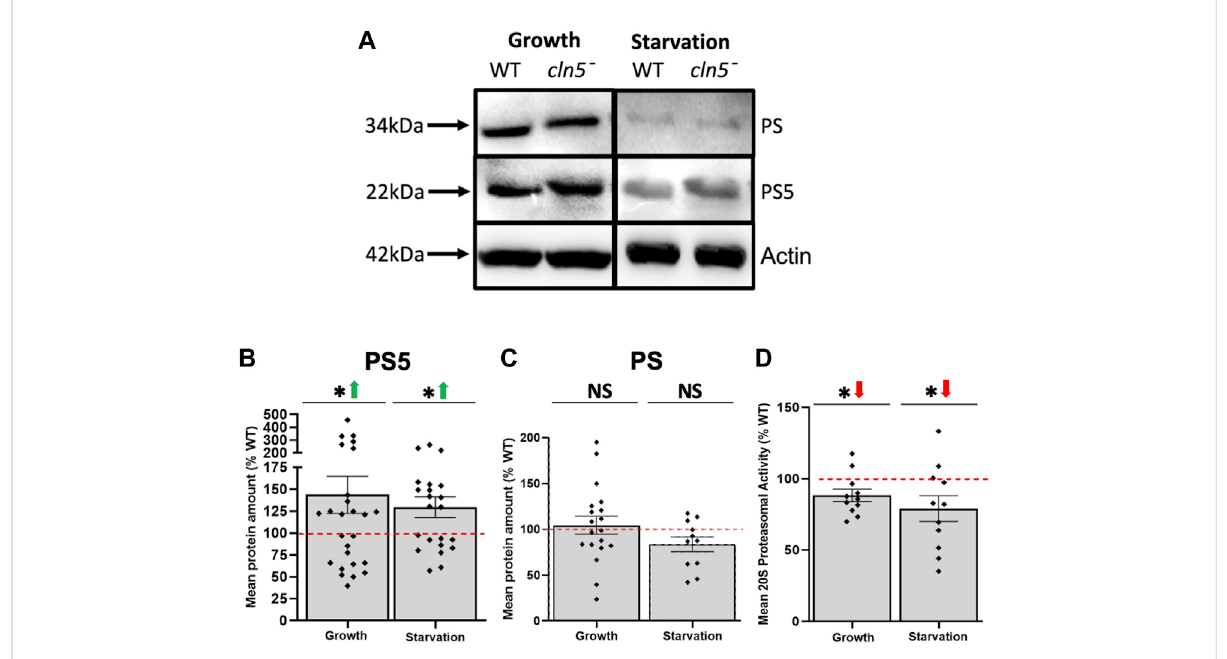
FIGURE 7 Loss of cln5 increases theabundance of a proteasomal subunit during growth and starvation but decreases proteasome 20S activity. (A) Whole cell(WC)lysatesfromgrowth-phaseand4 hstarvedWTand cln5 - -cellswereseparatedbySDS-PAGEandanalyzedbywesternblotting.Membranes wereprobedwithanti-PS, anti-PS5, andanti- β -actin(loading control).Fiji/ImageJ wasusedtoquantify (B) PS5and (C) PSproteinbands,whichwere then standardized against the levels of β -actin. Data presented as mean protein amount (% WT) ± SEM ( n ≥ 11). * p < 0.05 (one sample t